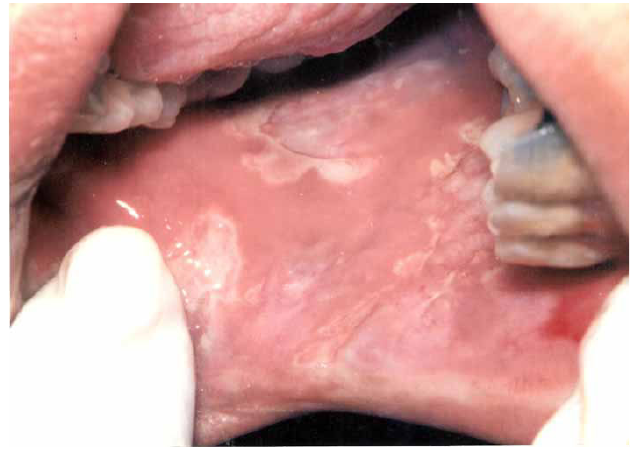
Fig. 2: Pemphigus vulgaris oral lesion (buccal